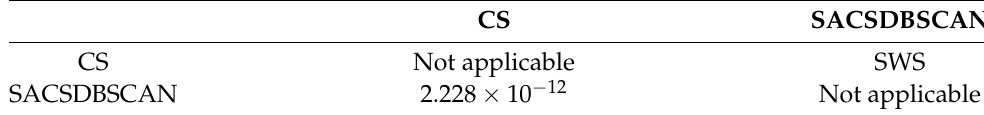
Table 10. p -values for instance 5.10.